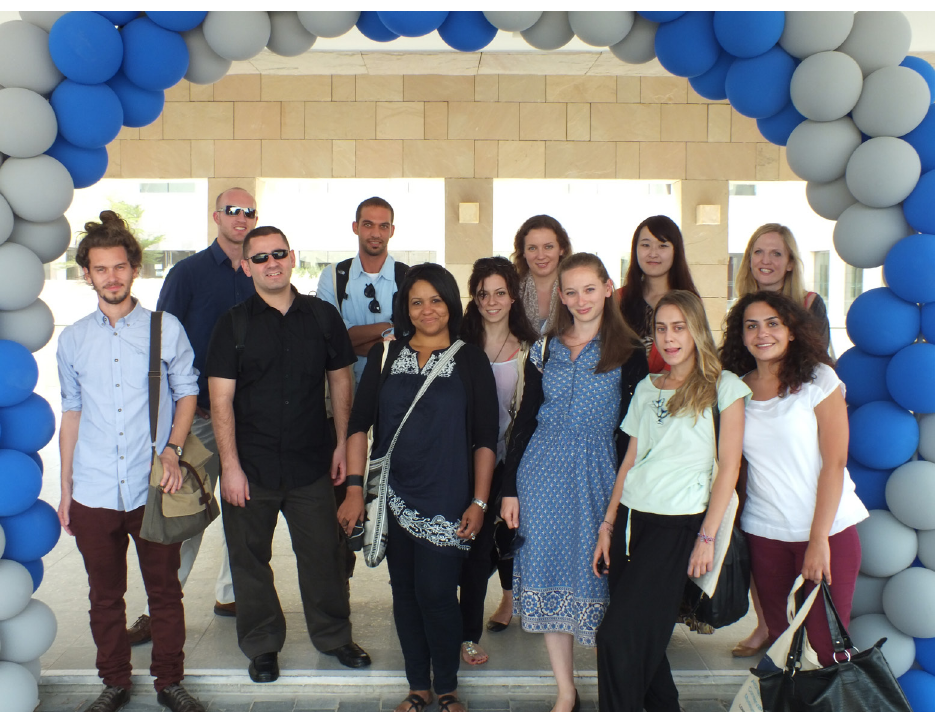
Fig. 1: International students during the inaugural Freshers’ Week at UCL Qatar (August